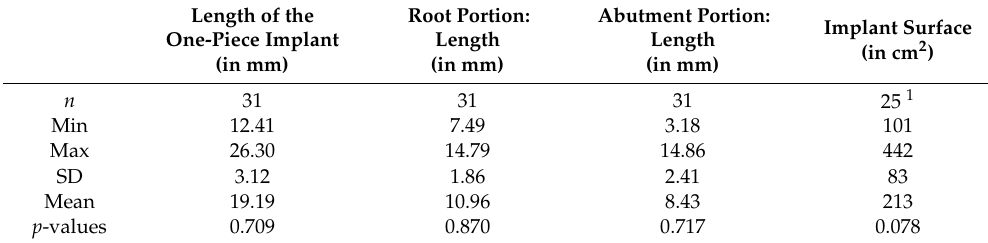
Table 4. RAI characteristics and p -values for investigated influence on MBL.